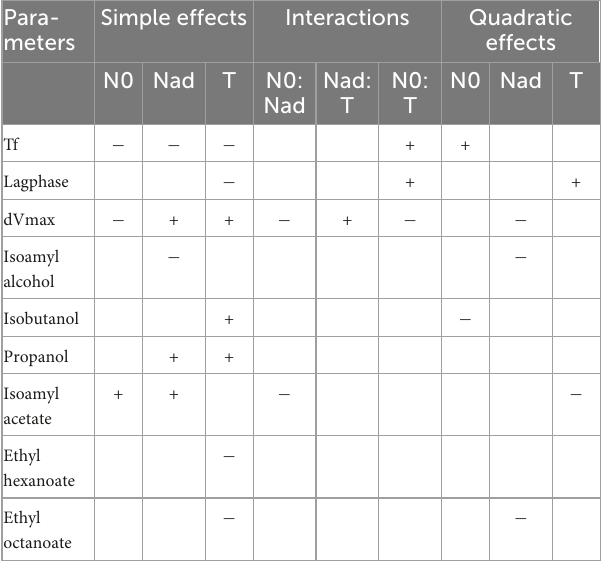
TABLE 3 Box-Behnken effects on final volatile compounds